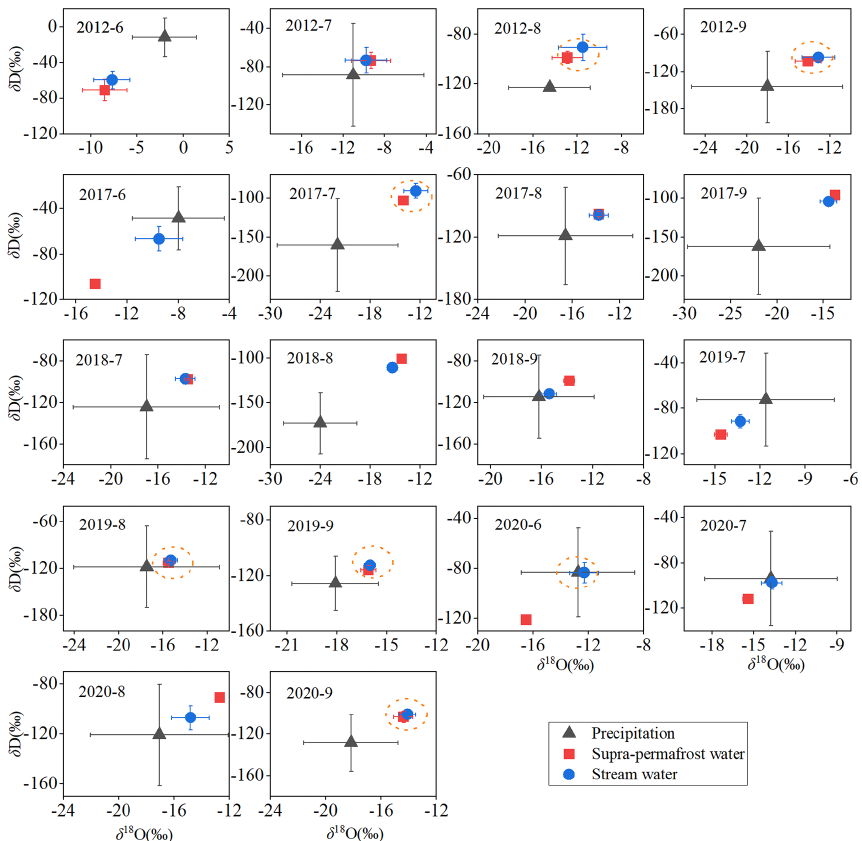
Figure 6. Monthly mixing diagram using the mean δ 18 O and δD values for stream water. The dotted orange ellipse indicates that the isotopic value in stream water is very close to the other